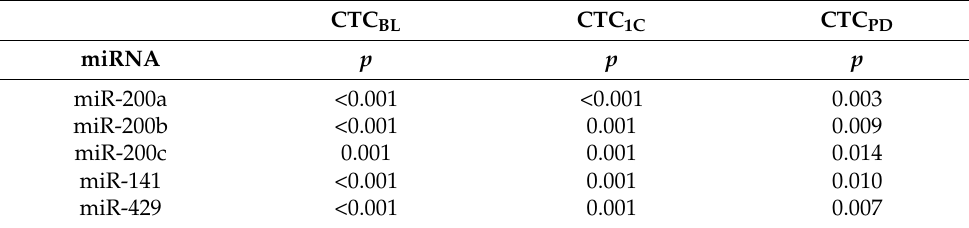
Table 3. Results of Student’s t -test comparing miRNA expression levels in patients with positive and negative CTC status.